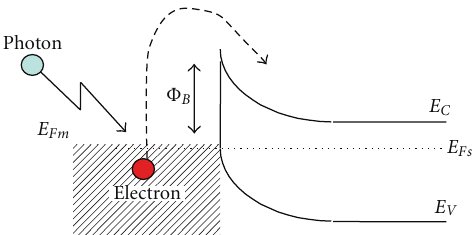
Figure 1: Energy band diagram for a metal-semiconductor junc-